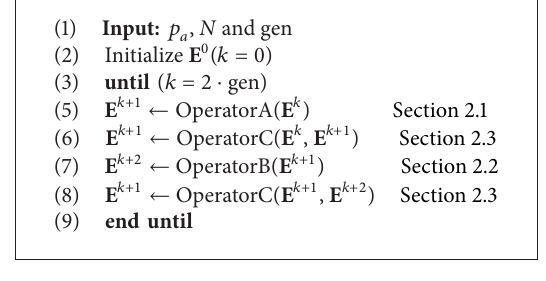
Algorithm 1: Cuckoo search (CS) algorithm.